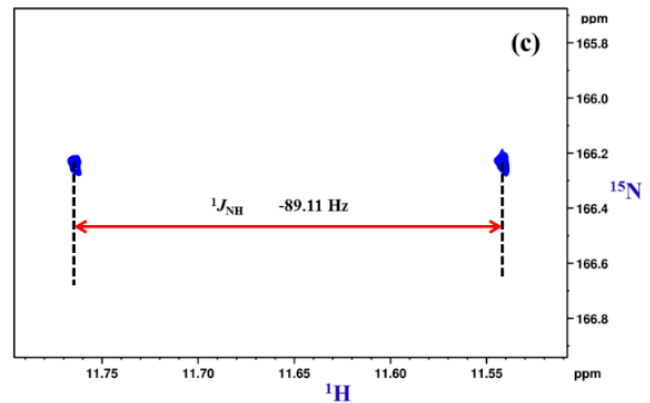
Figure 28. 800 MHz spectrum of molecule 26 in CDCl 3 ( a ) 1 H- 15 N-HSQC (NH-coupled) spectrum; ( b ) the chemical structure of molecule 1 and measured couplings with their signs; ( c ) 400 MHz 1 H- 15 N-HSQC spectrum (NH-coupled) in DMSO- d 6 .